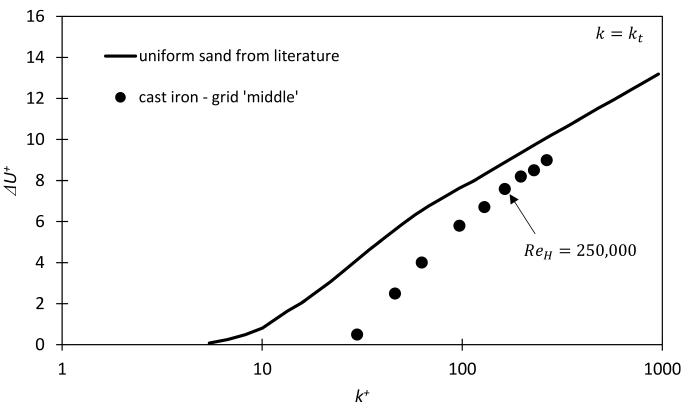
) for the cast iron roughness of the simulation with grid Figure 20. Roughness function ∆ u + = f ( k + t ‘middle’. The roughness function for uniform sand from Nikuradse [54] is included in the figure. Table 5. Calculated k s -values for the DPM simulation with the cast iron surface at the high Reynolds numbers. Cast Iron Re Grid ‘Middle’